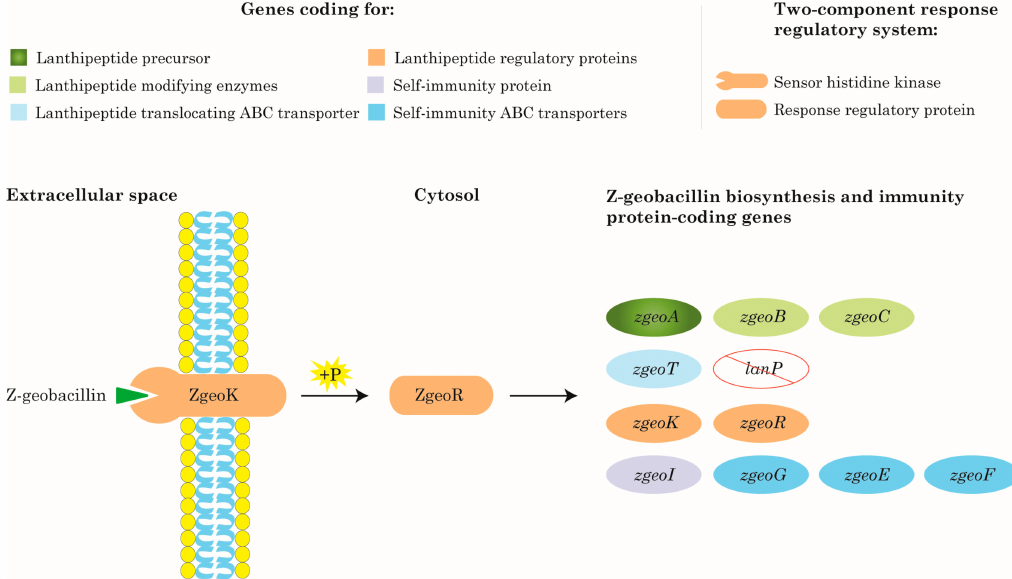
Figure 5. Schematic illustration of the putative biosynthesis pathway of Z-geobacillin. Amino acid sequences of the in silico -predicted proteins of strain ZGt-1 were annotated using the pathway mapping tool available from KEGG Automatic Annotation Server (KAAS) [61]. Predicted pathway indicated that the strain has all the genes required for the lanthipeptide biosynthesis, regulation and self-immunity, except for a dedicated protease-coding gene (represented as a white oval shape with a crossing red line). Details of the biosynthesis pathway are given in the text. The scheme was re-drawn after the KAAS-generated lanthipeptide biosynthesis pathway map of strain ZGt-1. Identical colors reflect correlated biological